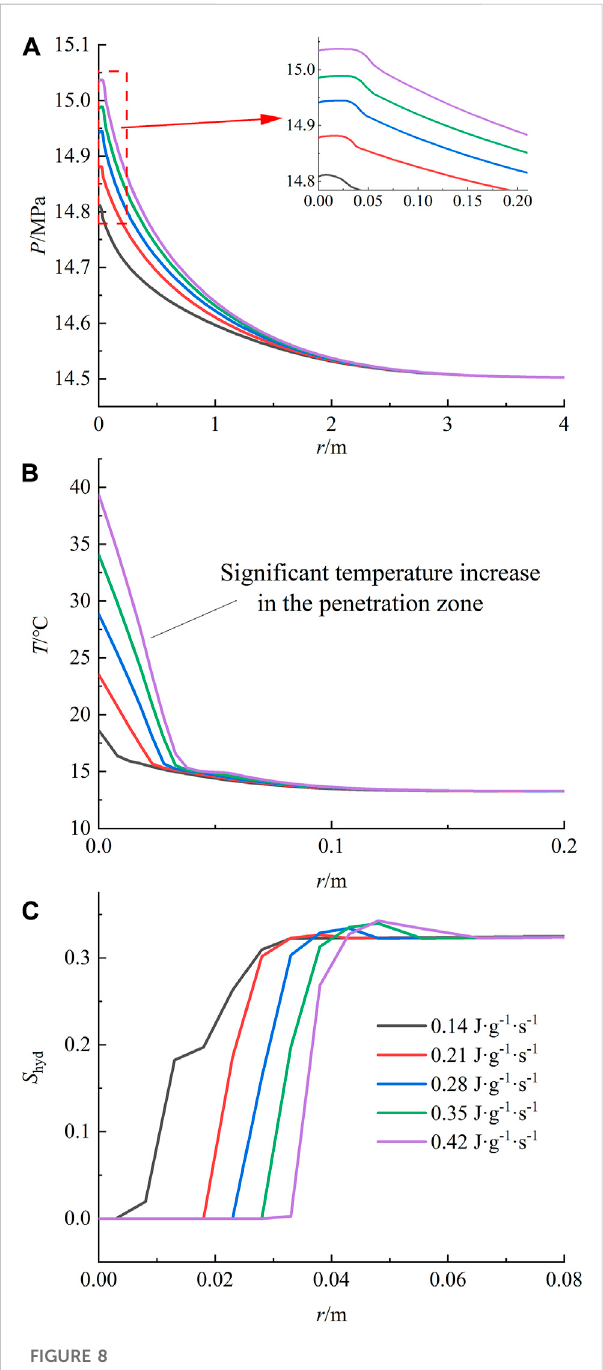
FIGURE 9 Changes in the main physical properties of the sediment around the wellbore at 25 min under varying cementing pressure differences. (A) Pressure. (B) Temperature. (C) Hydrate